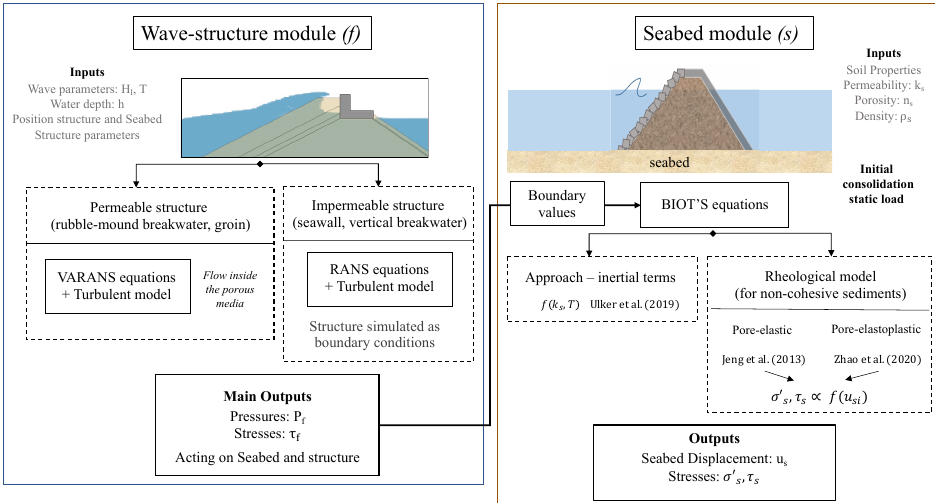
Figure 9. RANS/VARANS equations + Biot’s equations for modelling the wave–structure–seabed